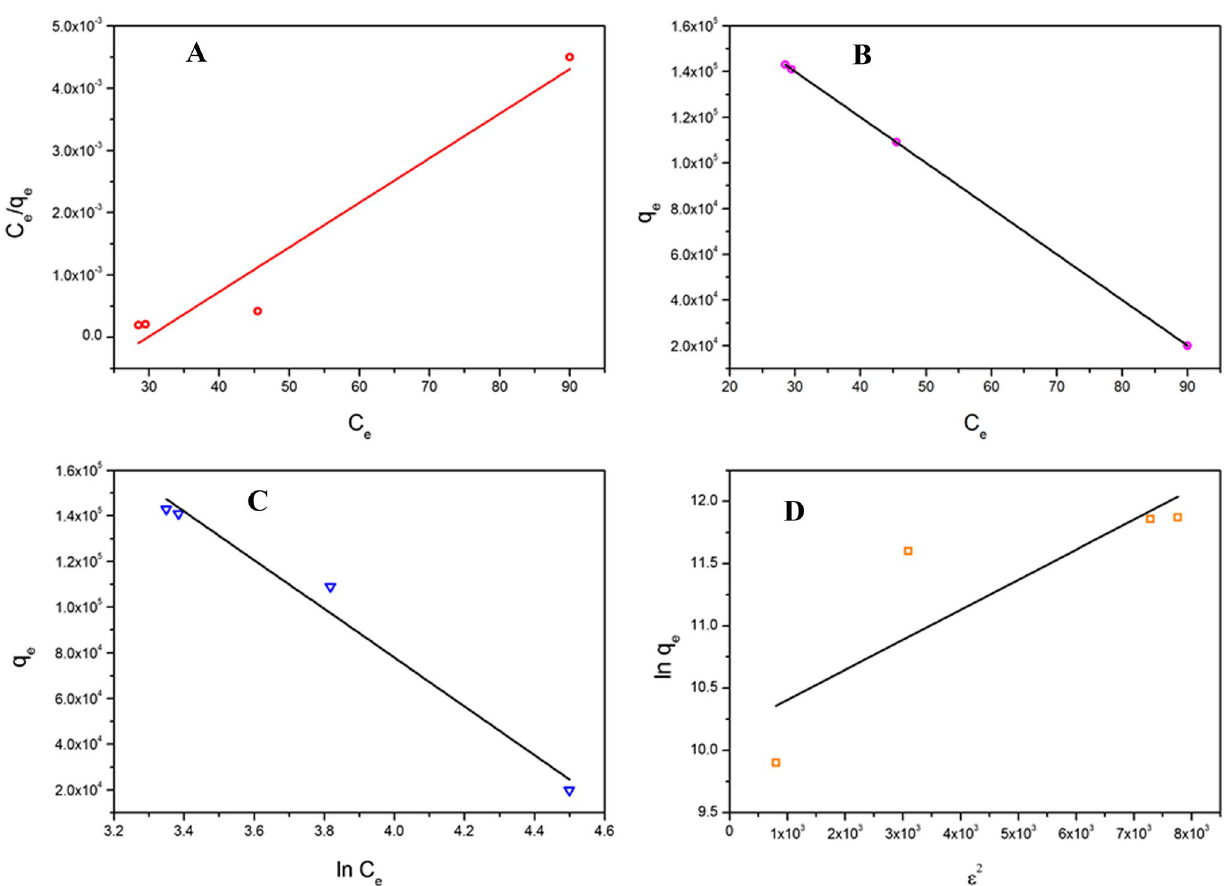
Fig. 10 Sorption isotherm for sorption of Fe(III)on Fe(III)-IIP, Langmuir sorption isotherm ( a ), Freundlich sorption isotherm ( b ), Tempkin sorp- tion isotherm ( c ), D–R sorption isotherm ( d